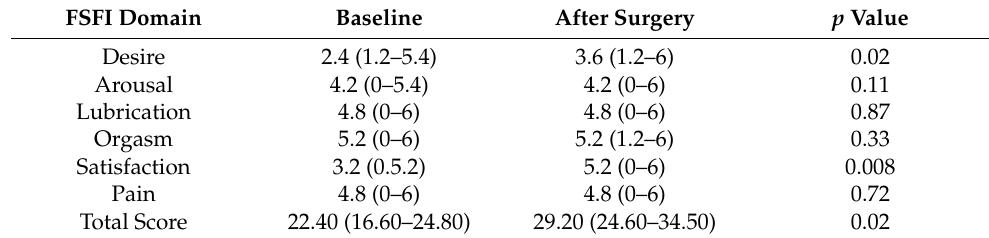
Table 2. FSFI scores before and after bulking agents.